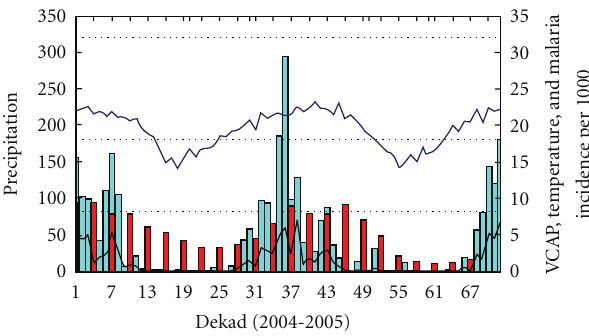
Figure 8: Region 1: the black line represents the VCAP values (values from 0 to 8), the blue bar represents rainfall (mm/dekad with values reaching 300 mm), the blue line represents temperature (temperature between 15 and 25 ◦ C), and the red bar represents malaria incidence per 1000 habitants.